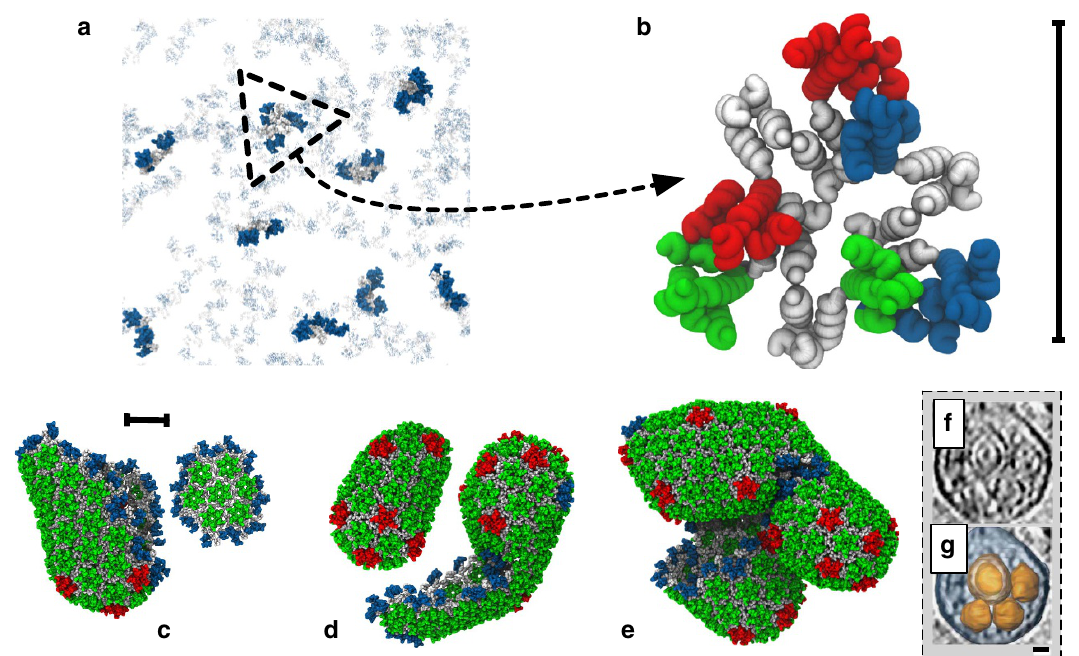
Figure 2 | Dimers of the CA protein are the units of self-assembly of HIV-1 capsid-like CG structures. ( a ) Simulation snapshot of a population of metastable trimer-of-dimers. CA NTDs are blue, with CTDs grey (non-aggregated CA shown transparent for clarity). ( b ) Detail of a CG trimer-of-dimers, where ‘edges’ are CA dimers, with two NTDs per triangle ‘vertex’. NTDs coloured by dimer for clarity, scale bar 10nm. Final simulation snapshots for r CR ¼ 200mgml (cid:2) 1 and [CA] ¼ 2mM ( c ), 3mM ( d ) and 4mM ( e ) are presented with NTDs coloured by monomer presence in a trimer (blue), pentamer (red) or hexamer (green). All CTDs grey, scale bar 20nm. ( f ) Multiple aggregated capsid structures as revealed by electron cryotomography, with capsid structures highlighted in orange ( g ). Scale bar, 20nm; f and g adapted from ref.